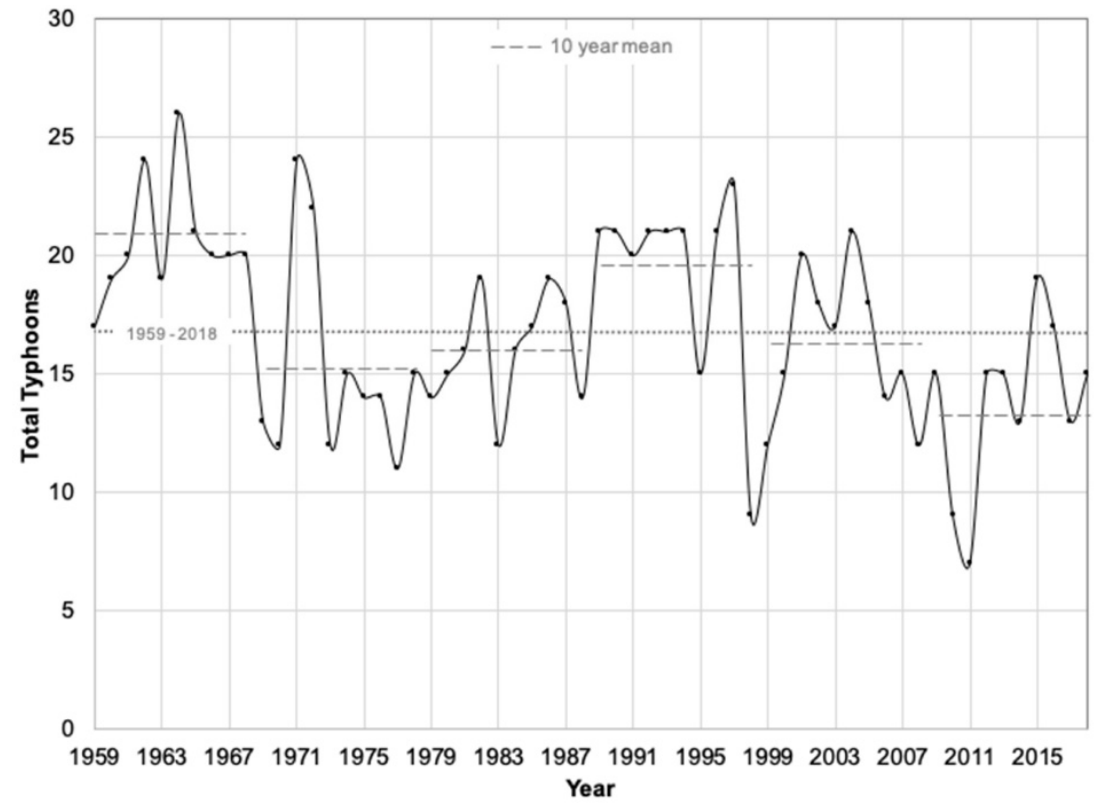
Figure 4. Total number of typhoons from 1959 through 2018. The average for 1959–2018 was 16.85 typhoons, which is shown along with 10-year average lines.